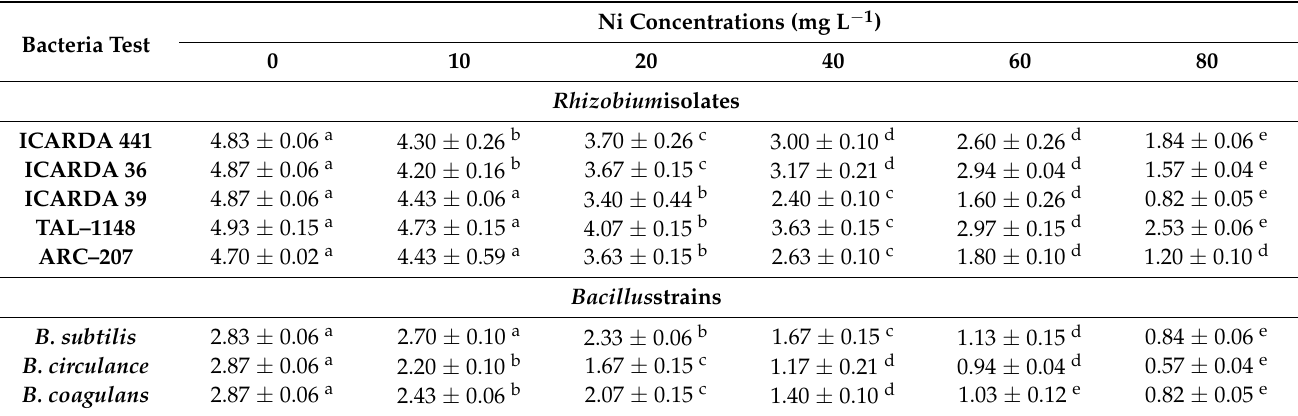
Table 1. Growth patterns of Rhizobium isolates and Bacillus strains in different concentrations (0, 10, 20, 40, 60, and 80 mg L − 1 ) of